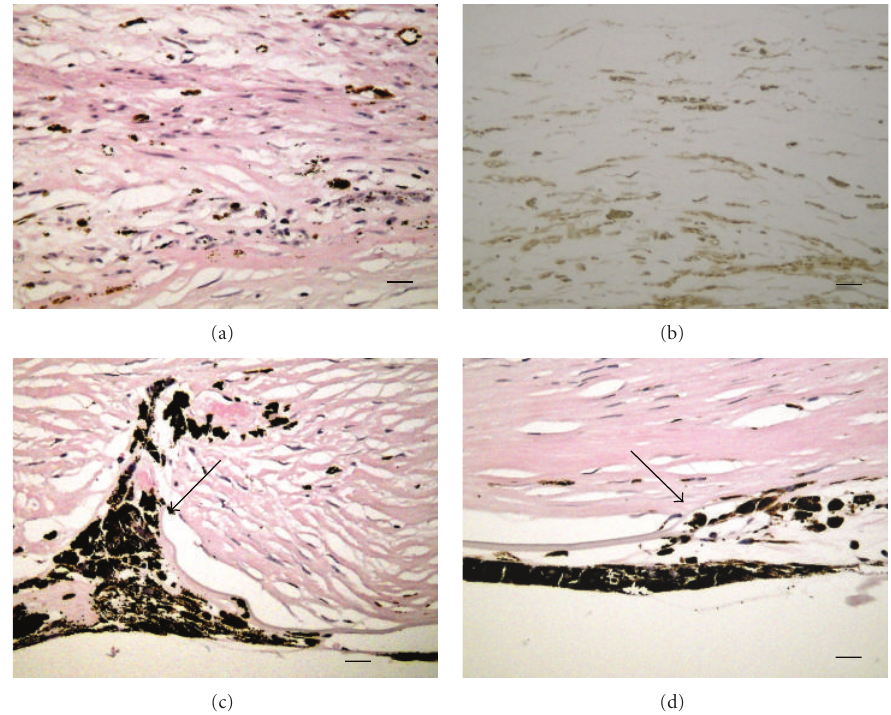
Figure 5: The corneal stroma with HE staining (a). The stroma was consisted of irregular collagen, fibroblast-like cells, pigmented cells, and presumed inflammatory cells. Immunohistochemistry for α SMA (b). The fibroblast-like cells labeled by antibodies against α SMA were scattered in corneal stroma. Posterior surface of the cornea with HE staining (c) and (d). Arrow: the end of Descemet’s membrane. Bar: 10 μ m.